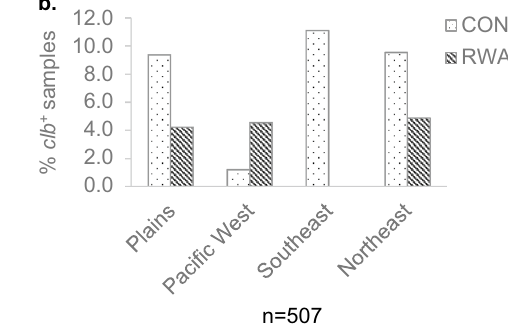
Prevalence of clb + E. coli in retail ground beef. To estimate the prevalence of clb + E. coli in ground beef, 1,074 generic E. coli previously isolated from 507 retail ground beef samples collected from 6 US cities 24 were screened. Overall, prevalence of clb + E. coli in ground beef samples was found to be 5.5% (28/507) (Fig. 2). With two isolates selected per sample 24 , 4.1% (44/1074) of the generic E. coli from ground beef carried clb in their genome. clb + E. coli appeared significantly lower ( P < 0.05) among isolates recovered from ground beef with RWA label claims (2.4%) compared to isolates from CONV ground beef (5.5%). However, there was no significant difference on a per sample basis where clb + E. coli were isolated from 9 of 240 RWA and 19 of 267 CONV samples. Interestingly, among the samples from the southwestern region, clb + E. coli were entirely absent from RWA samples (Fig. 2). Prevalence of clb appears to be lowest among isolates from ground beef purchased in the Pacific West region (1.9%) compared to Plains (5.3%), Southeast (4.6%), and North East (5.5%) regions (Supplementary Fig. S2).